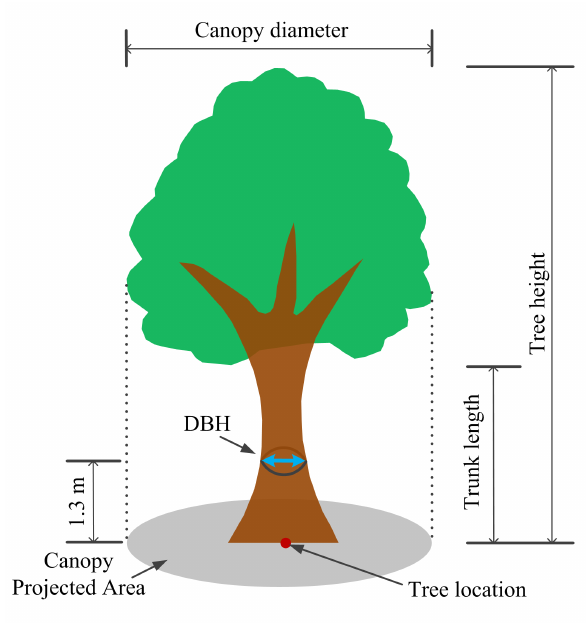
Figure 1: An illustration of tree parameters extracted in this study. Location and height are estimated by determining the position of the points at the bottom of each trunk and the vertical extend of the tree points respectively. Notably, the length of trunks was estimated by determining the maximum gradient of the number of voxels at each vertical layer. Figure 2 shows an example of a voxelization of one tree. Figure 2 ( a ) and ( b ) are projections on plane XOZ and Y OZ respectively. There are 30 vertical layers and tree points are colored from blue to red by height.